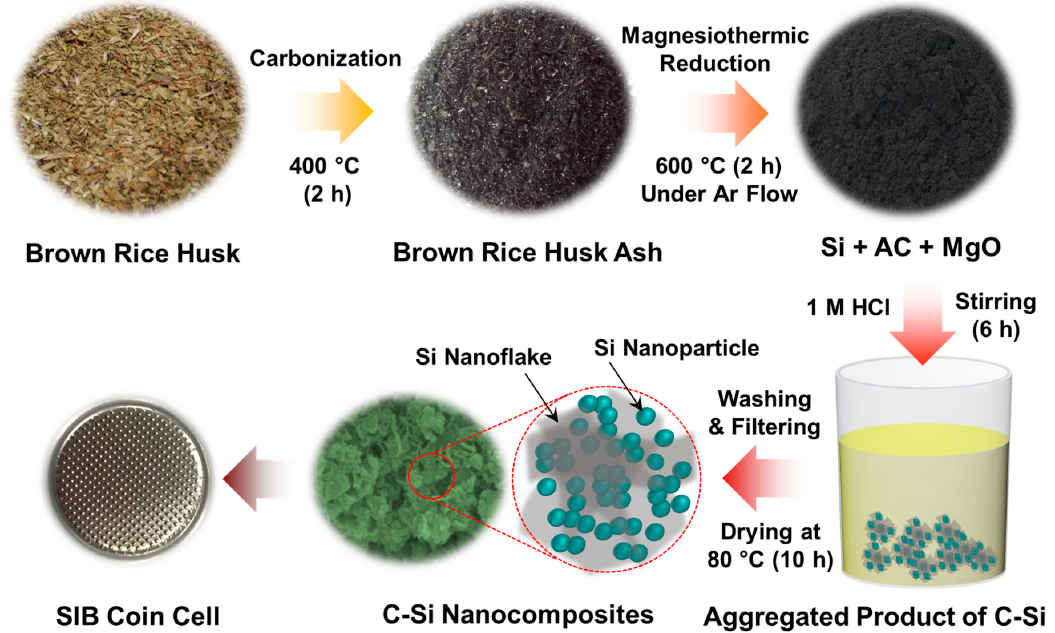
Figure 1. Schematic illustration for the one-pot synthesis of the C-Si nanocomposites via facile magnesiothermic reduction using BRH ashes.